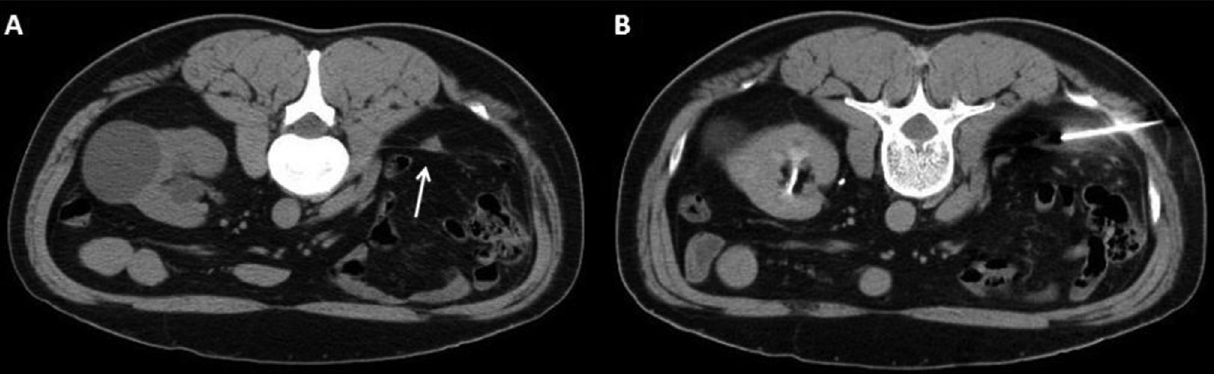
Figure 1 - A) Computed tomography of the abdomen without contrast IV injection in the ventral decubitus with nodular imaging in the right renal sinus (arrow). B) Moment of CT-guided injection of Sn- 99m Tc into the